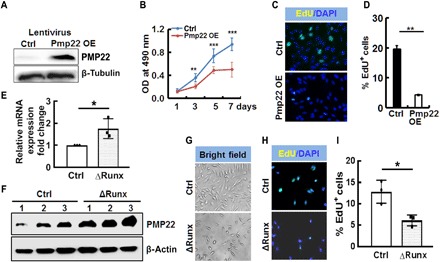
Pmp22 inhibits mouse neurofibroma SC proliferation, and overexpression of Pmp22 induces cell senescence.(A) Western blot showing PMP22 expression on lentivirus control (Ctrl) or PMP22 overexpression (OE) lentivirus-transduced mouse neurofibroma SCs. β-Tubulin was used as a loading control. (B) MTS assay showing significantly decreased cell growth in Pmp22 overexpressing mouse neurofibroma SCs compared with lentivirus control cells starting at day 3 and stopping cell growth at day 5. OD, optical density. (C) Representative EdU (green) and 4′,6-diamidino-2-phenylindole (DAPI) (blue) images on control (top) and Pmp22 overexpressing (bottom) mouse neurofibroma SCs. (D) Quantification of percentage of EdU+ cells on control (black bar) and Pmp22 overexpressing cells (white bar). (E) qRT-PCR of the relative mRNA expression of Pmp22 on ΔRunx cells normalized to control (n = 3 per group). (F) Representative Western blot of Pmp22 on three independent controls and three independent ΔRunx cells. (G) Representative bright-field images of mouse neurofibroma SCs. Top (control): Cells were transduced by lentivirus, but the RUNX-Pmp22–binding sites remained intact. Bottom (ΔRunx-Pmp22): Homozygous deletion of five putative RUNX-binding sites in Pmp22 gene by CRISPR-Cas9 approach (ΔRunx). (H) Representative EdU (green) and DAPI (blue) images on control (top) and ΔRunx (bottom) mouse neurofibroma SCs. (I) Quantification of percentage of EdU+ cells on control (white bar; n = 3) and ΔRunx cells (light gray bar; n = 3). *P < 0.05, **P < 0.01, and ***P < 0.001.